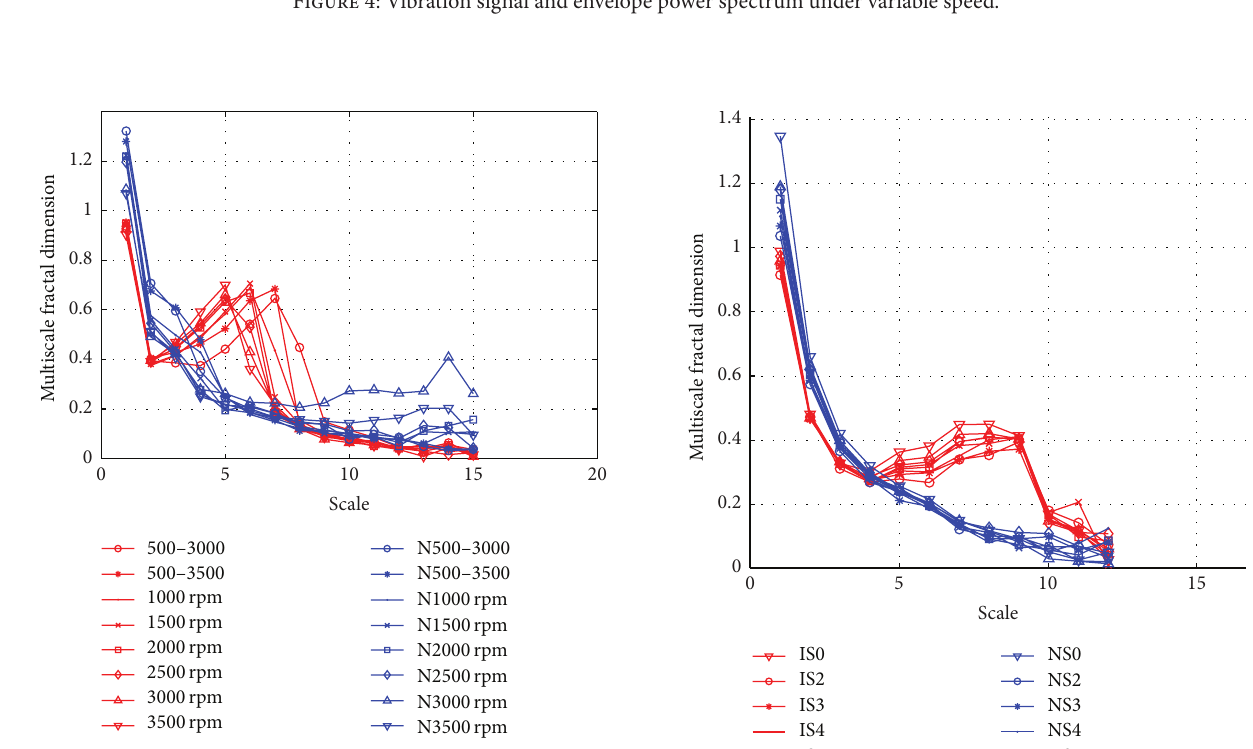
Figure 5: Multiscale general fractal dimensions under variable speed.